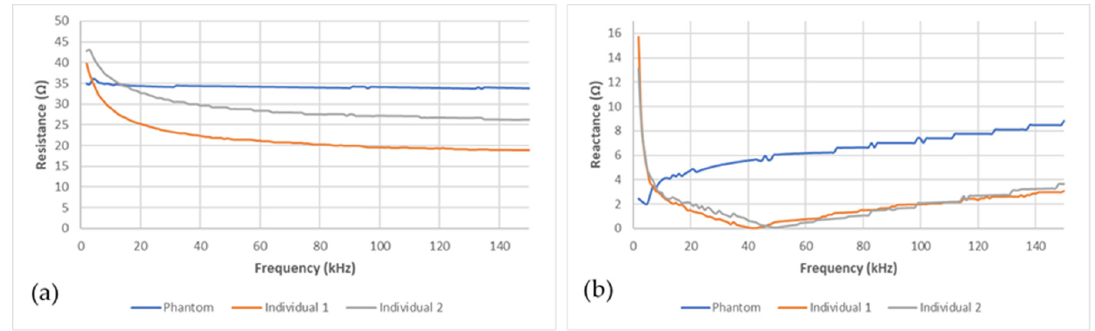
Figure 6. Comparison between the phantom’s (blue line) ( a ) resistance and ( b ) reactance and the human ones (grey and red lines).